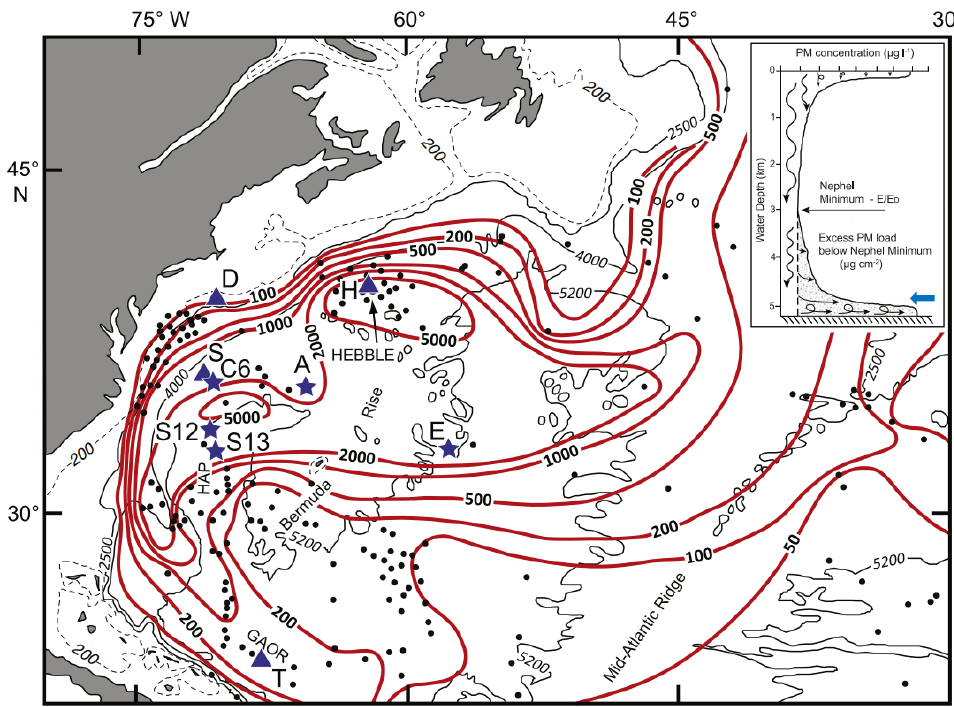
Figure 2. Distribution of excess particulate matter load (red contours, in µ g/cm 2 ) in the bottom nepheloid layer of the western North Atlantic Ocean, with nephelometer data from the HEBBLE area [55]. Nephelometer profile locations are indicated by dots. Bottom Ocean Monitor (BOM) loca- tions (triangles) and mooring sites (stars) are identified. Black dashed and solid lines are bathymetric contours. The insert shows an idealized nephelometer profile. Looping arrows indicate surface-water and benthic boundary layer mixing. Horizontal arrows indicate lateral transport of resuspended sediment. Wavy vertical arrows indicate particles sinking from surface waters. Blue arrow indicates the DWBC location. Table 1. Statistics of the nepheloid layers in the marginal